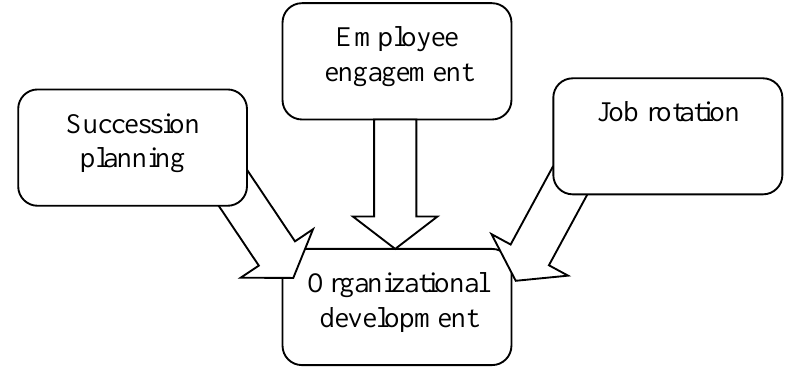
Fig. 1. Researcher conceptual model,